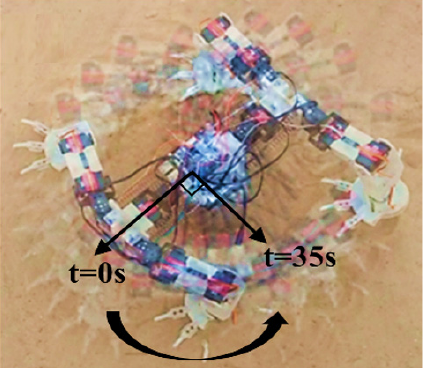
Figure 21. Turning performances for a quarter locomotion cycle.